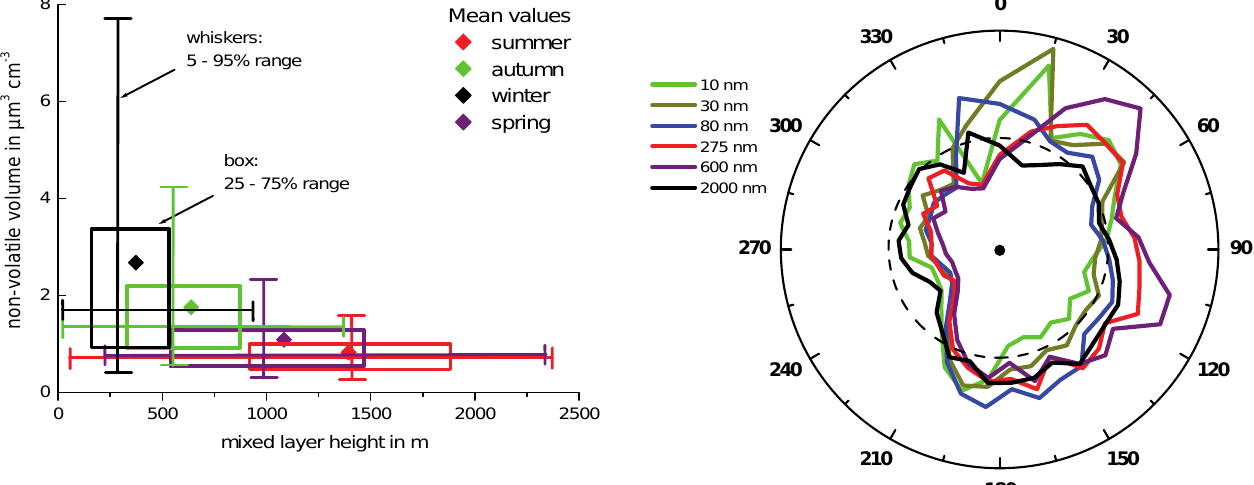
Fig. 11. Relationship between the mixed layer height and the non- volatile particle volume concentration ( D p < 800nm). The Figure indicates mean values as well as 25–75% and 5–95% percentile ranges (box, and whiskers, respectively).